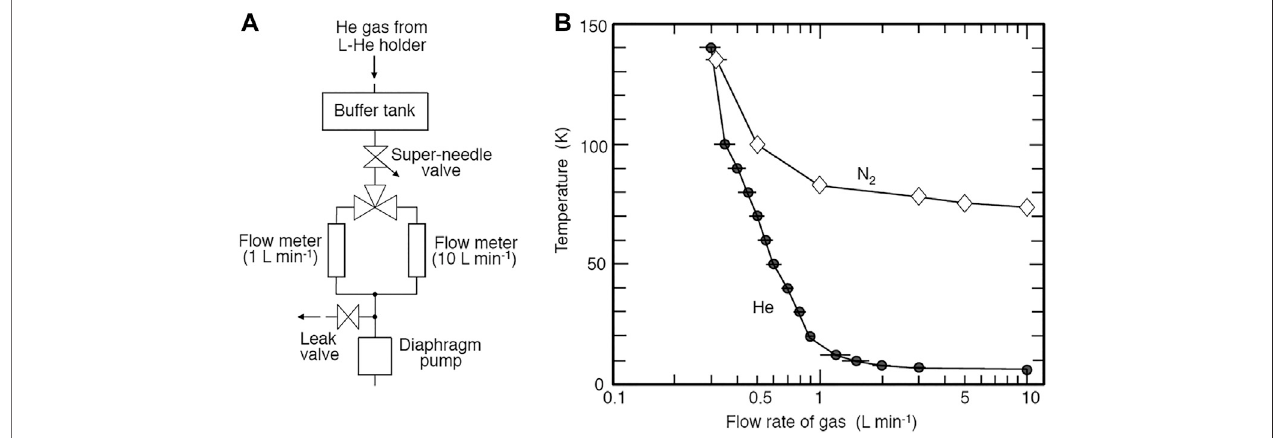
FIGURE 4 | Methods for measuring the thickness of a-H 2 O by focusing to both sides of a-H 2 O (A – C) , and by shadowing (D) . Blue and purple triangles and red circles show dif fi cult and easy points for focusing, respectively.